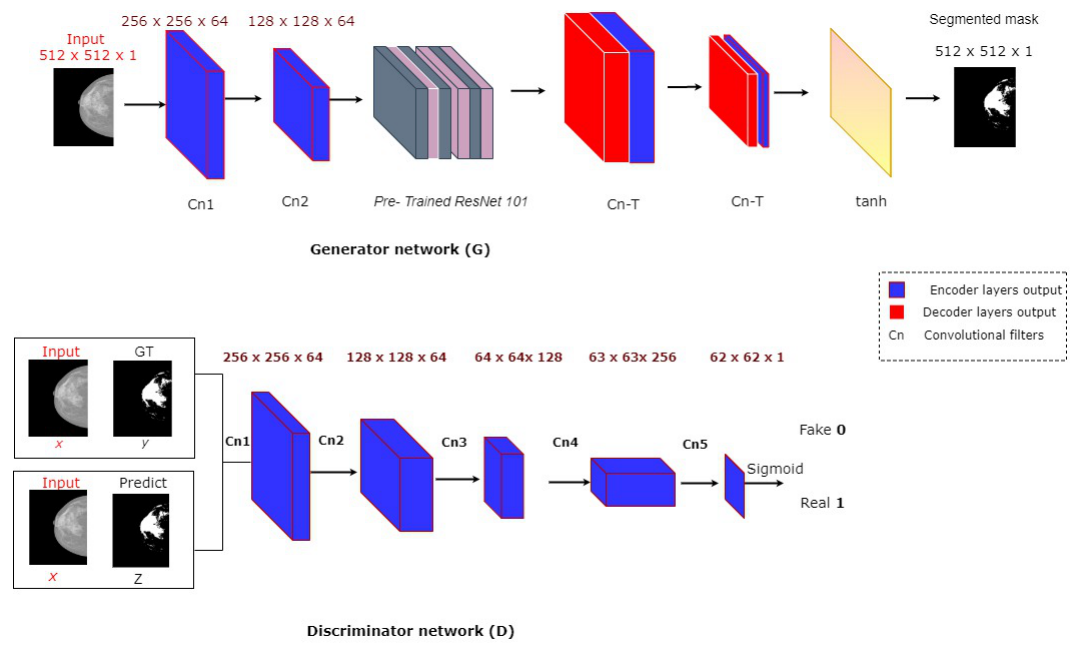
Figure 5. cGAN framework for breast density